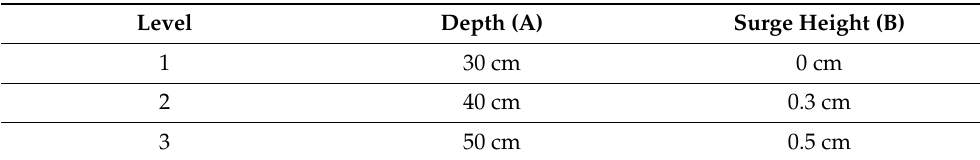
Table 4. The factor-level orthogonal testing design of thermal characteristics of surface under swell conditions.